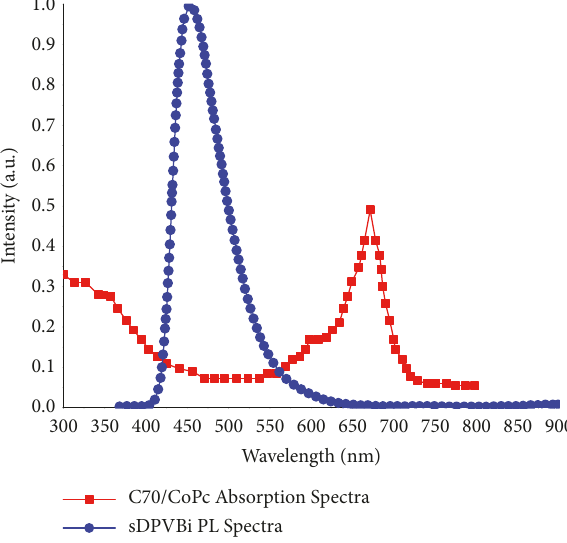
Figure 13: Current efficiency plot of devices B1 and B2.